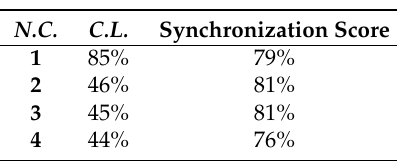
Table 4. Confidence level and synchronization score as a function of N.C. ; σ = 1, N . R . = 15, O . R . = 4, and ± ∆ R =